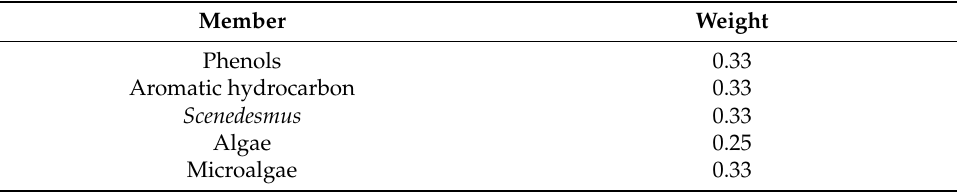
Figure 11. Thematic network for the first period (2000–2005). Table 5. The weight of lines connected to main theme